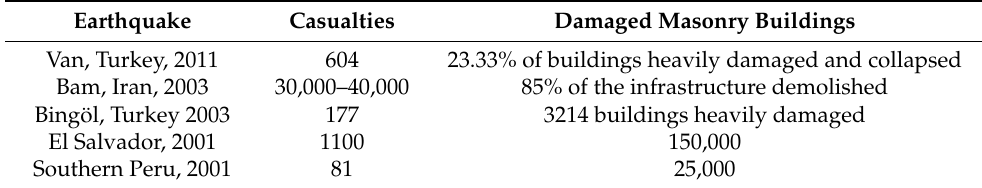
Table 2. Effects of previous earthquakes on adobe buildings [16–18].